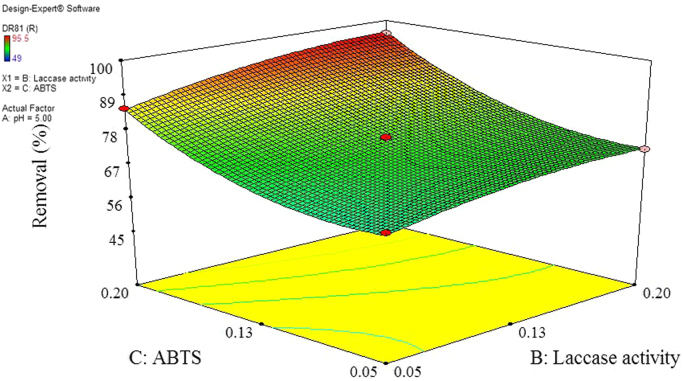
3D surface plot from BBD showing the interaction effects of ABTS and laccase activity on elimination of DR81.